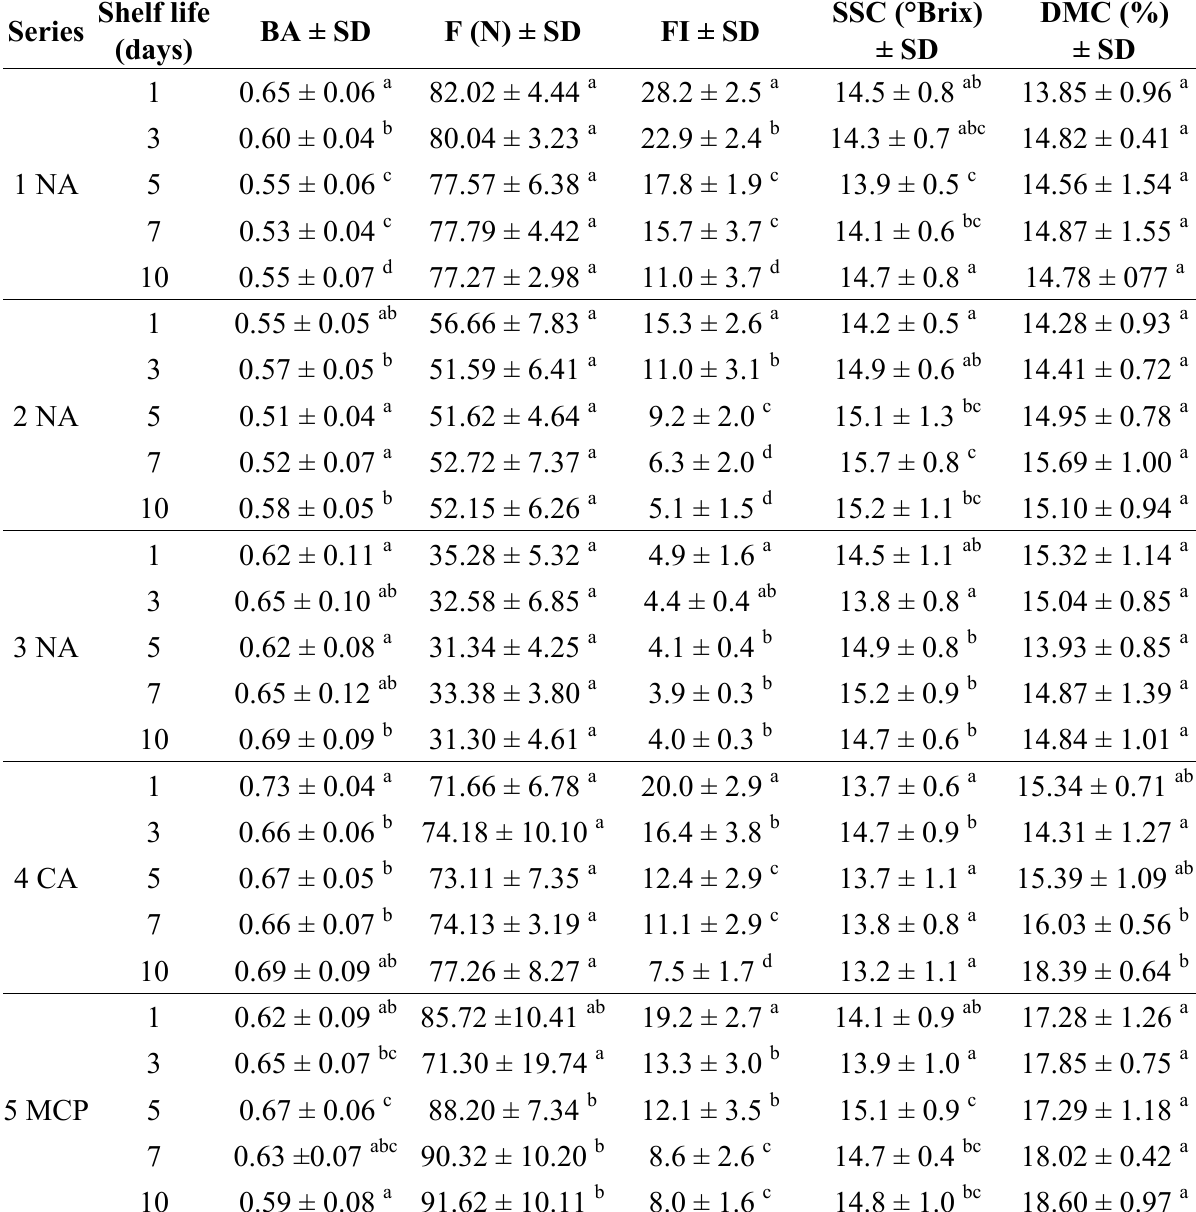
Table 1. Mean values of biospeckle activity (BA) and quality attributes for ‘Pinova’ (F–firmness, FI–firmness index, SSC–soluble solids content, DMC–dry matter content) of apple during shelf-life. SD–standard deviation, the same letters a–e mean no significant difference at the level of α = 0.05 between superscripted